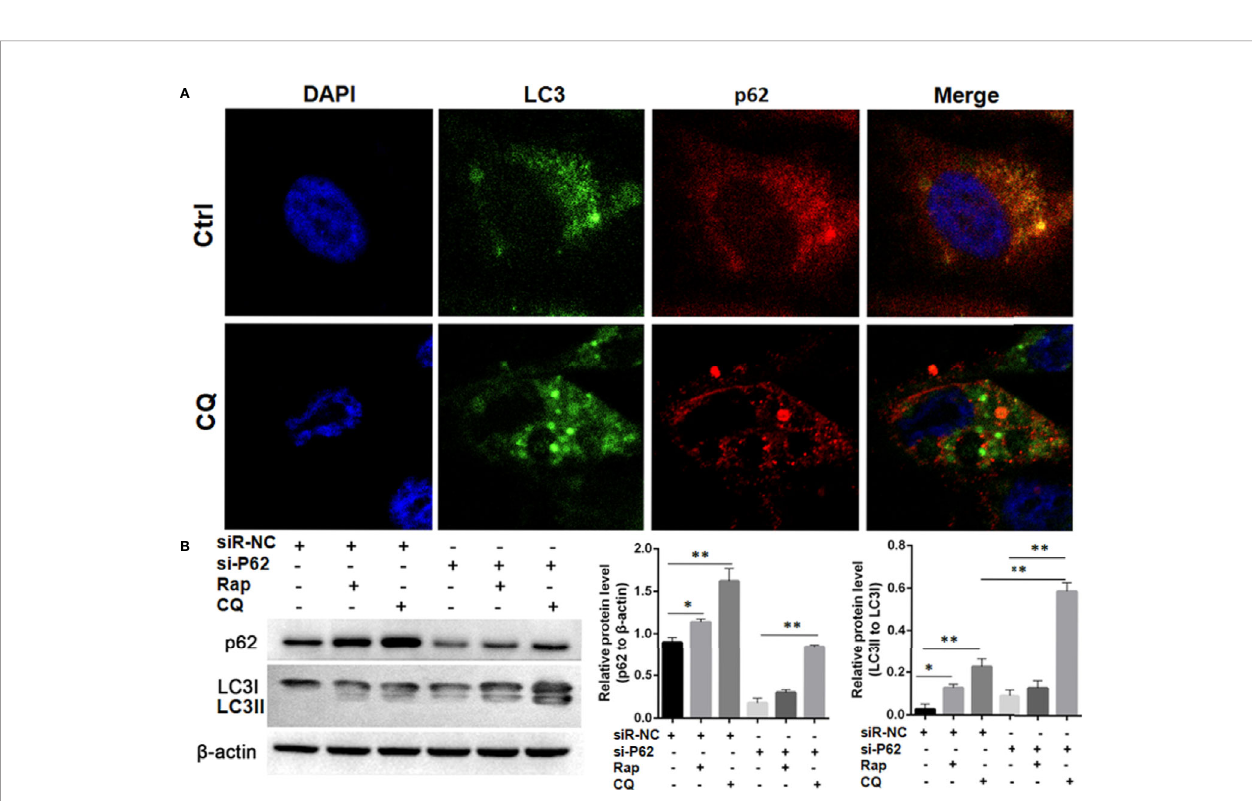
FIGURE 7 | Autophagy fl ux detection upon treating with Chloroquine (CQ) or Rapamycin (Rap) in wild type and p62 silencing A549 cells. (A) Double immuno fl uorescent staining of p62 and LC3 protein in A549 cells treated with CQ (20 m M/L for 48h). Punctate GFP-LC3 emits green fl uorescence, and punctuate mCherry-p62 emits red fl uorescence. In merged panel p62 protein only partly colocalized with LC3 protein. (B) Changes of p62 and LC3 protein was detected upon Rap or CQ in different A549 cells. Signi fi cant switch of LC3 I to LC3 II was detected in different A549 cells treated with CQ or Rap, which demonstrates that autophagy fl ux is activated. Meanwhile, increased p62 expression is induced instead of degradation as autophagy substrate. In p62 silencing A549 cells, Signi fi cant switch of LC3 I to LC3 II was detected upon treating with CQ but not with Rap. Ctrl, untreated A549 cells; siR-p62, small interfering p62 RNA transfected cells; siR-NC, siR-p62 scrambled control; CQ, Chloroquine; Rap, Rapamycin. *P < 0.05, **P < 0.01